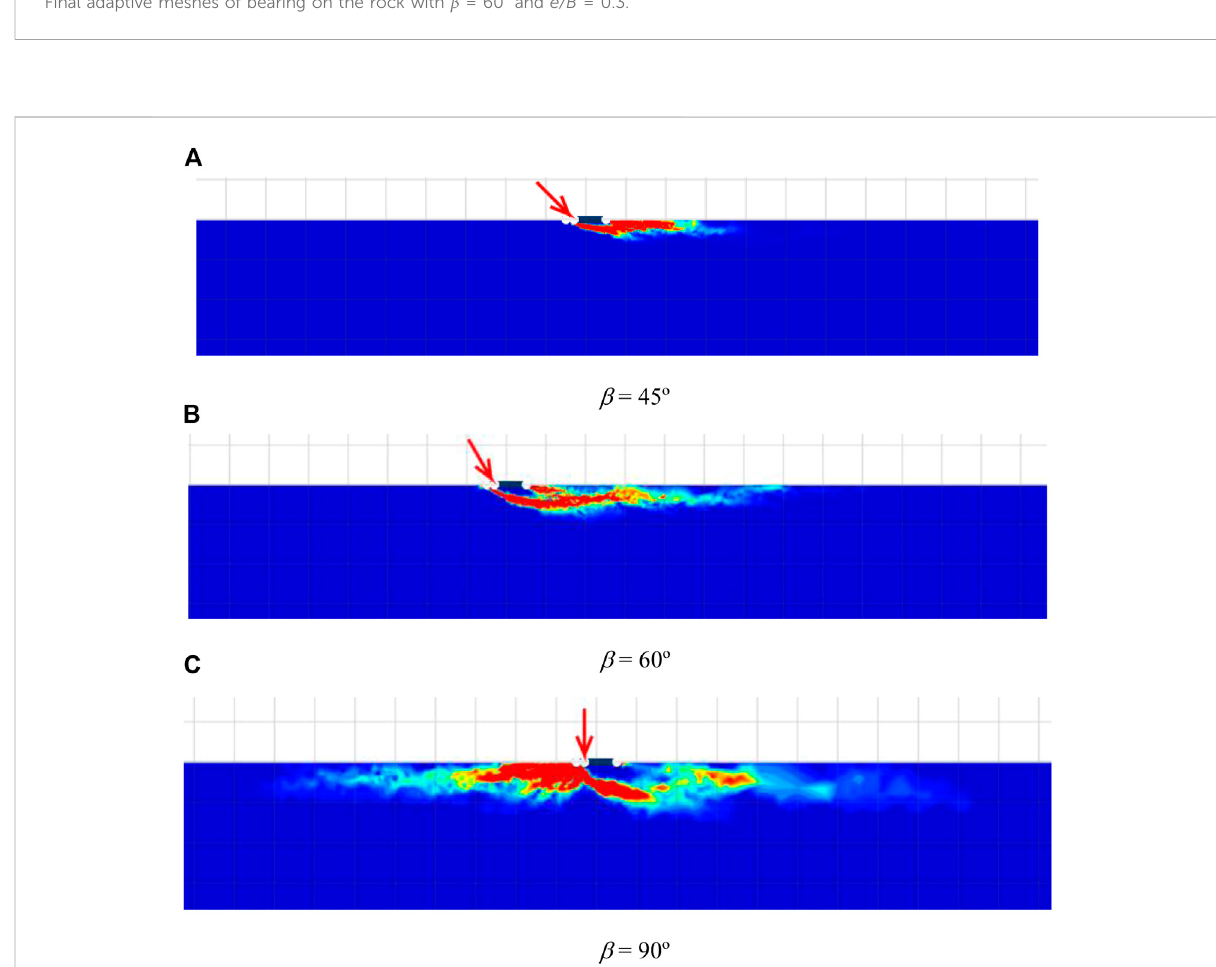
FIGURE 4 Shear dissipations for various β with. e/B = 0.3, GSI = 100, m i = 5, γ B/ σ ci = 0, and α = 1. (A) β = 45 ° (B) β = 60 ° (C) β = 90 °